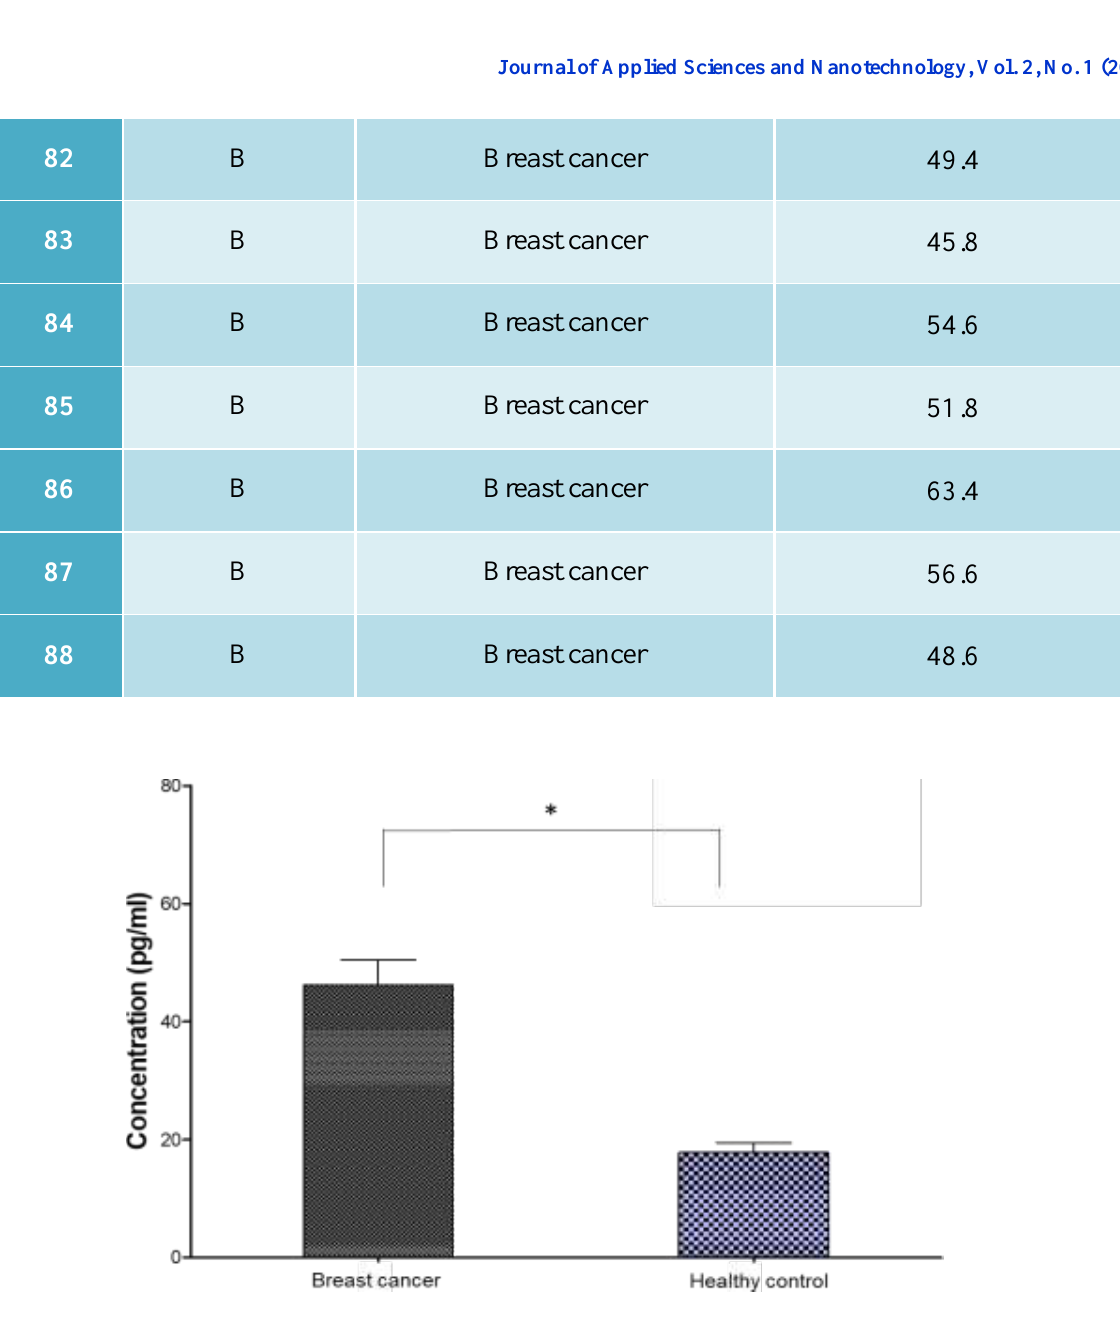
Figure 4: Level of Interferon gamma (IFN-γ) in serum of healthy subjects and women with cancer